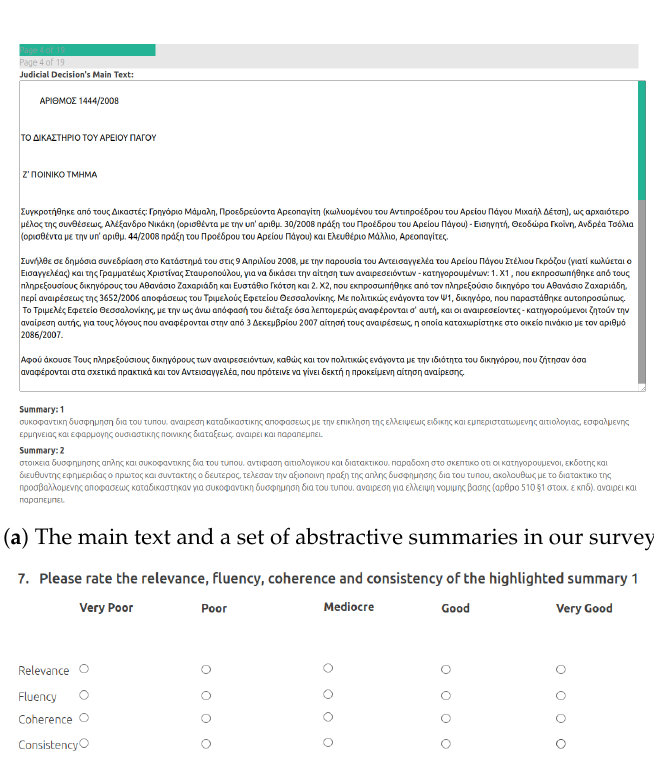
( b ) The evaluation metrics interface for abstractive summarization in our survey. Figure 9. Two screen captures of the abstractive summarization evaluation in our survey.